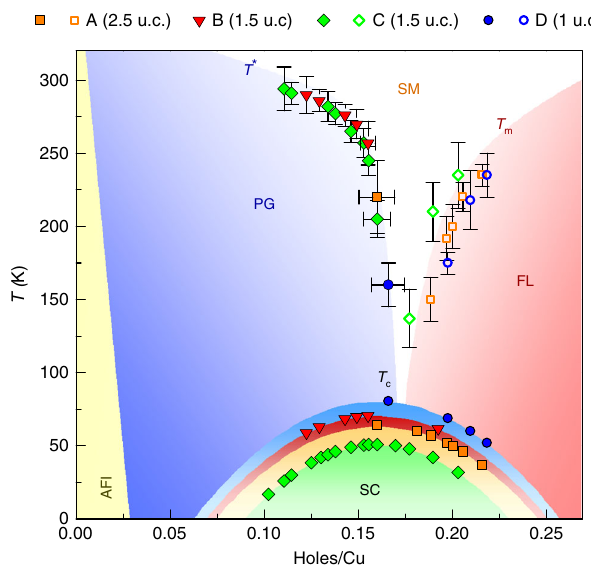
Fig. 3 Phase diagram of 2D space charge doped BSCCO-2212. Of the 32 measured R S ( T ) curves, 26 were of the quality needed for extracting characteristic temperatures. The characteristic temperatures T * ( fi lled symbols), T m (open symbols), and T c ( fi lled symbols on the domes) extracted for the four devices of this study are plotted as a function of doping (holes/Cu). They demarcate the boundaries of the pseudogap region (PG), the strange metal region (SM), the Fermi liquid region (FM), and the superconducting dome (SC). The different colors of the domes re fl ect the shrinking of the dome with disorder. The error on characteristic temperatures is estimated during their extraction while that on doping depends on T c through Eq. (1) and is signi fi cant around optimal doping. Where not shown, it is of the size of the data point or values at the fi xed, low temperature of 120 K 18, 19 for all doping values. Figure 1 shows an overview of the R S vs. T characteristics